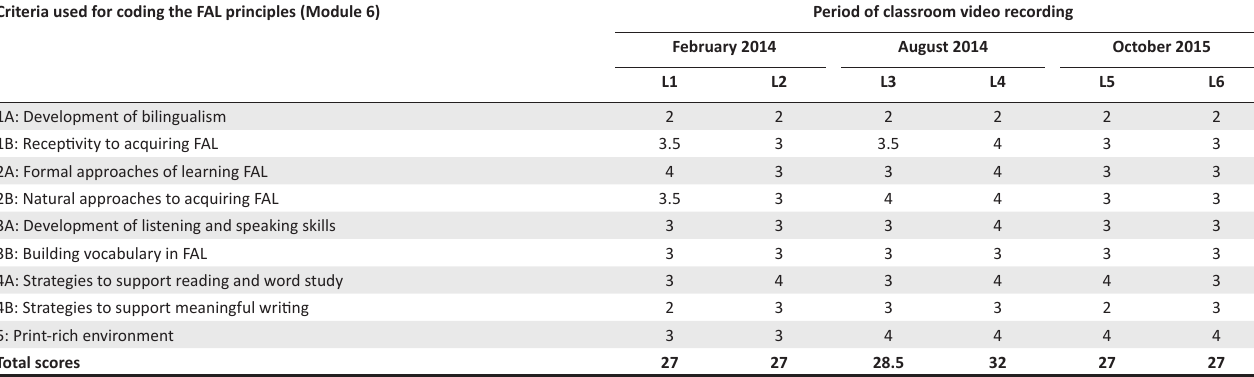
TABLE 3: The extent to which Anne’s practice reflects the principles of teaching English as a First Additional Language. Criteria used for coding the FAL principles (Module